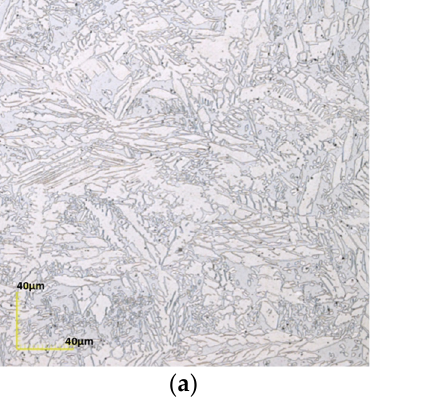
Figure 8. Microstructure observed in the FZ of the sample subjected to postwelding solution heat treatment for 10 s at 1050 °C: ( a ) edge; ( b ) 1/4 region; ( c ) 1/2 region.